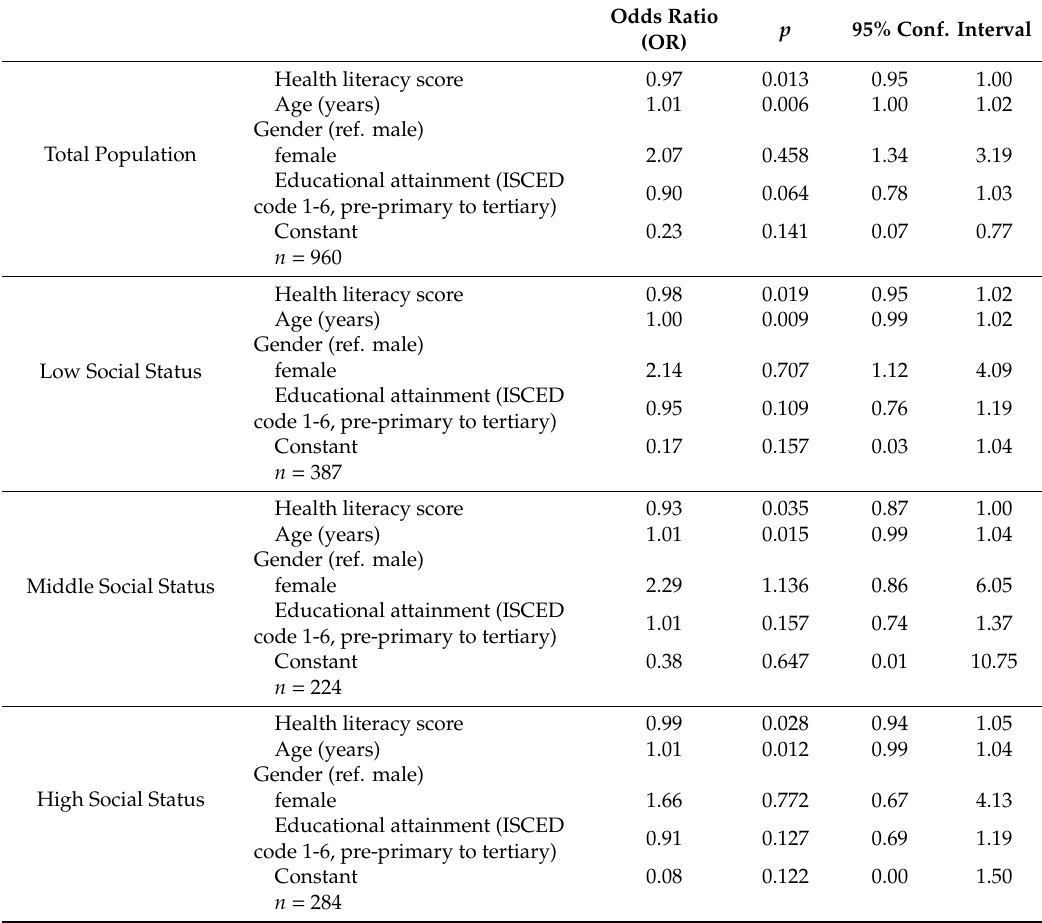
Table A6. Healthcare utilisation (3 + hospital visits in the past 12 months) logistic